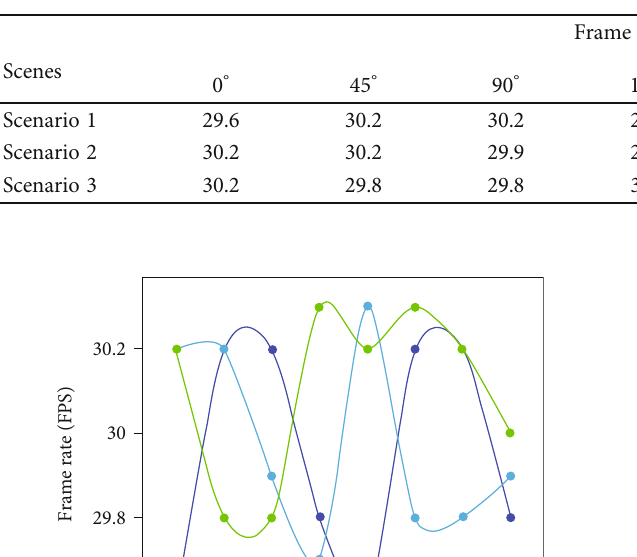
Table 3: E ff ect video streaming frame